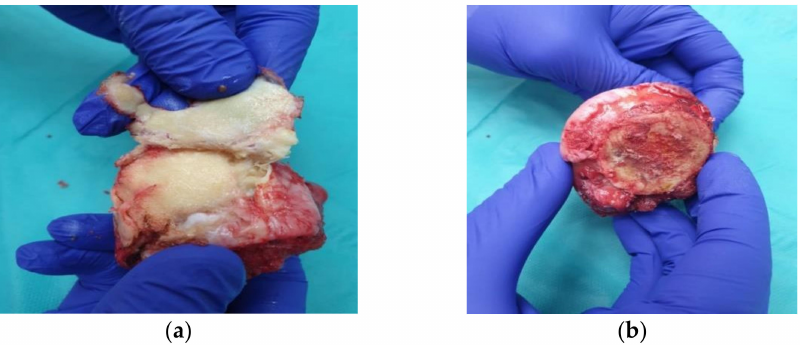
Figure 1. ( a ) Cartilage denudation and necrosis of the femoral head-macroscopic appearance and ( b ) Femoral head osteotomy site-thermo-generated necrosis of adjacent bone tissue. Residual tissue pieces have been extracted from the medullar area of the femoral